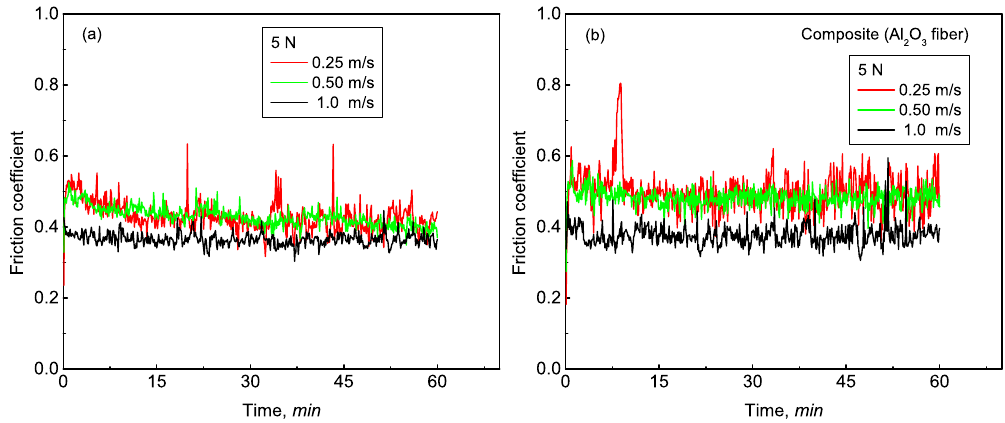
Figure 3. Typical friction-coefficient curves vs. testing time of ( a ) the Al–12Si–CuNiMg matrix alloy under applied load of 5 N and ( b ) the Al 2 O 3 fiber-reinforced composite under applied load of 5